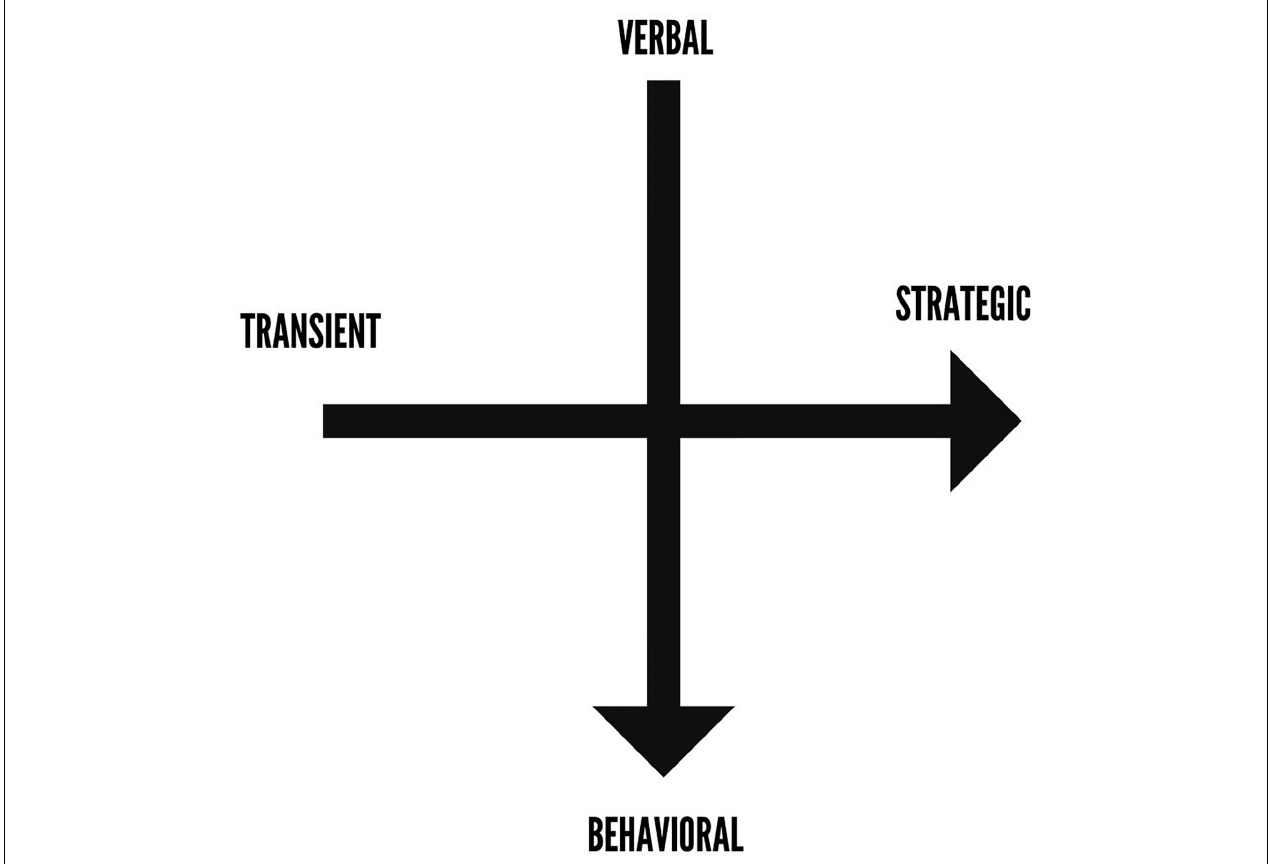
FIGURE 2 | Axes of dark participation in